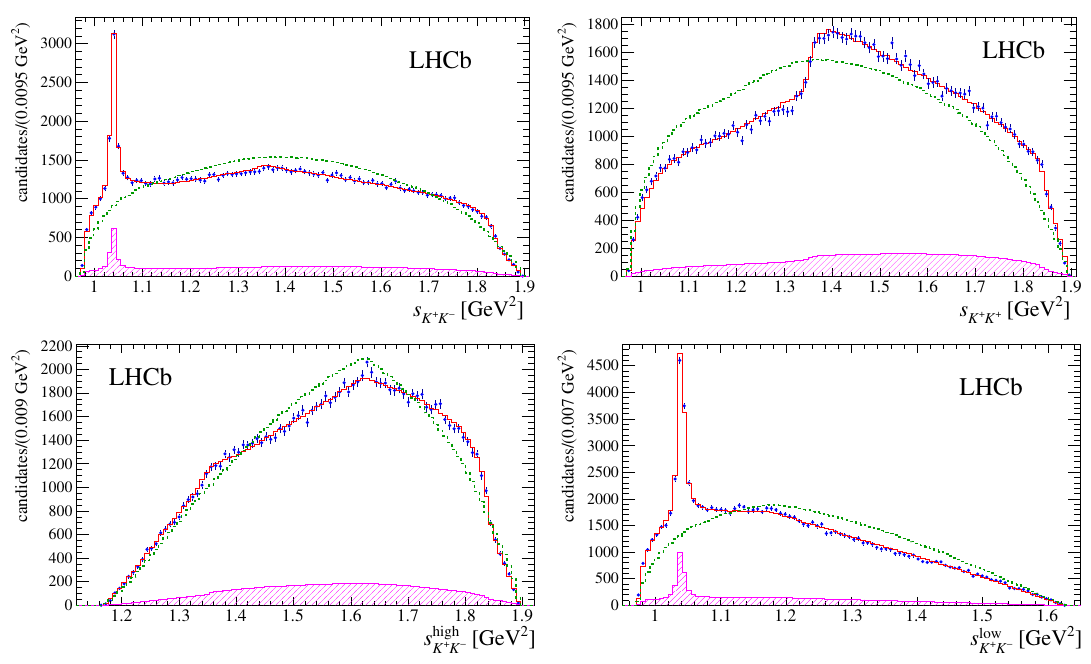
Figure 11 . Projections of the Dalitz plot onto (top left) s , (top right) s , (bottom left) K + K (cid:0) K + K + s high and (bottom right) s low axes, with the (cid:12)t result with the Triple-M amplitude superim- K + K (cid:0) K + K (cid:0) posed, whereas the dashed green line is the phase space distribution weighted by the e(cid:14)ciency. The magenta histogram represents the contribution from the background.